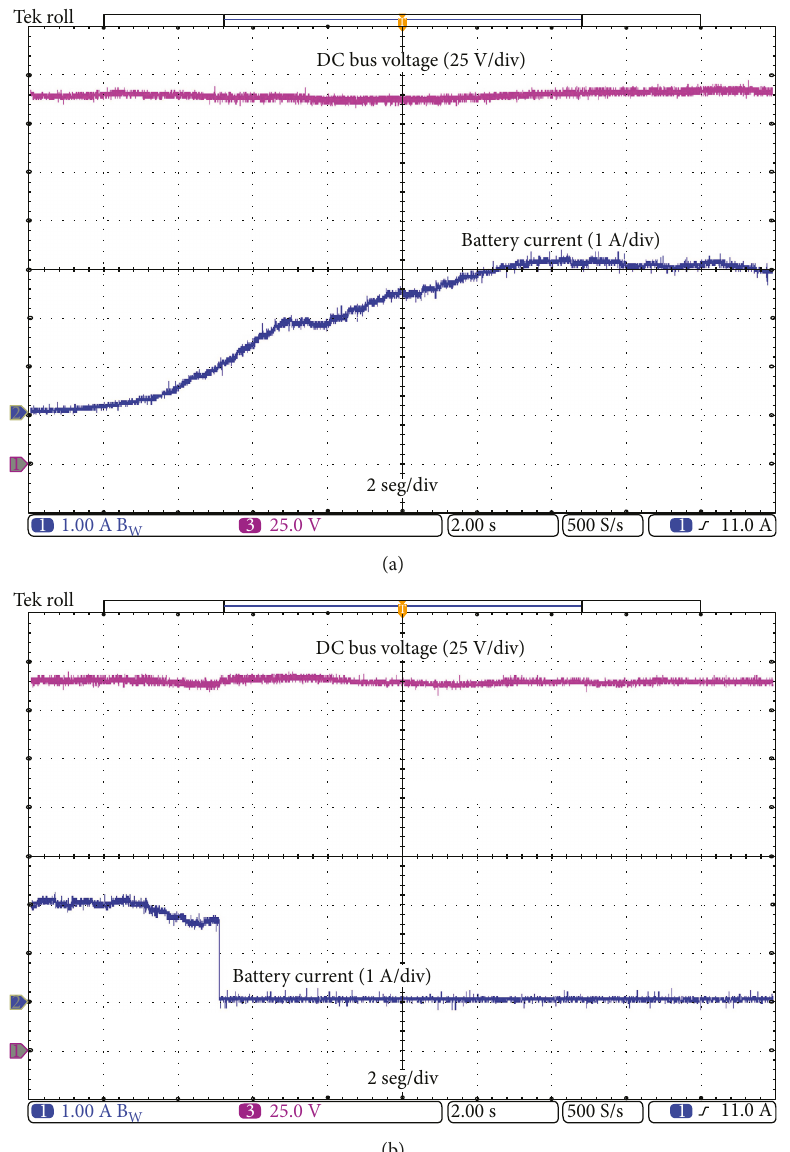
Figure 9: (a) Activation of the bidirectional converter in buck topology and (b) bidirectional converter turned-o ff